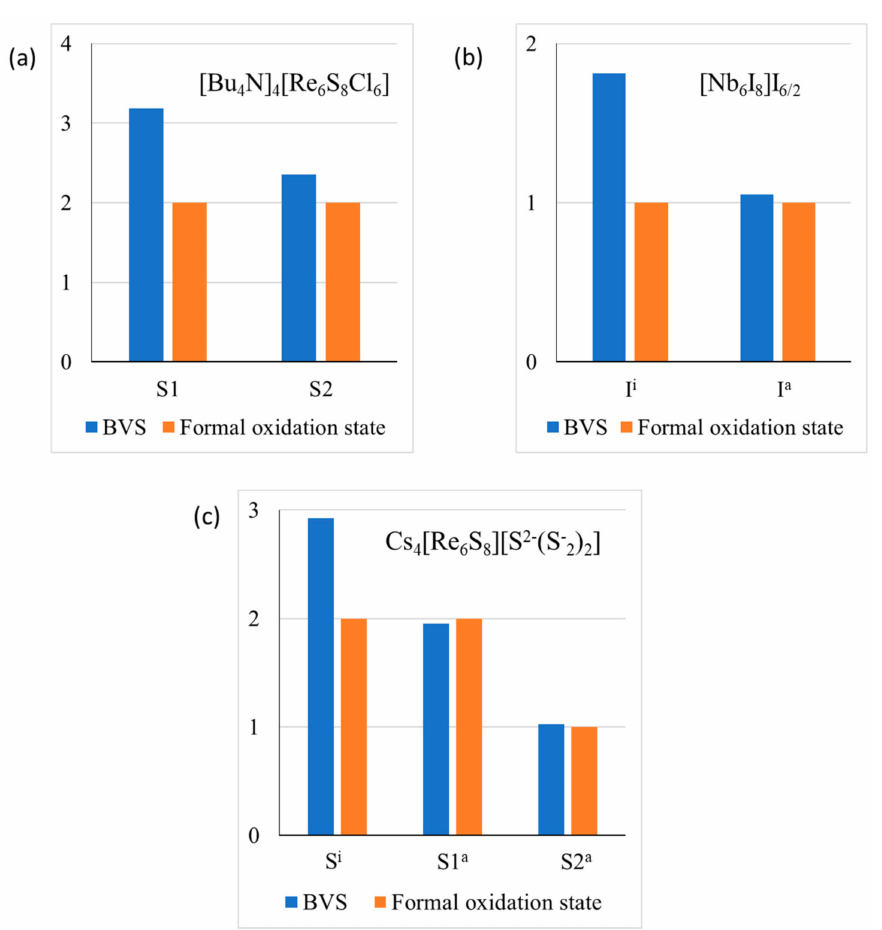
Figure 6. Valence violations for anions in [Bu 4 N] 4 [Re 6 S 8 Cl 6 ] ( a ), Nb 6 I 11 ( b ) and Cs 4 Re 6 S 13 ( c ). Here absolute values of the oxidation state are